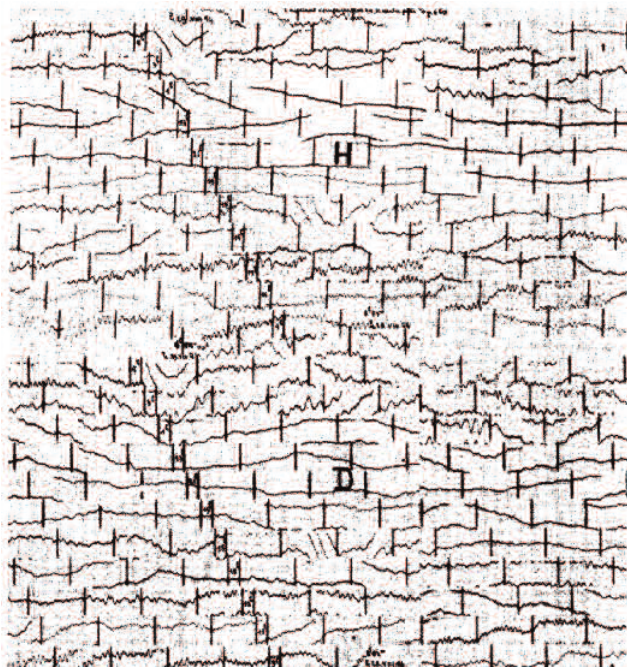
Figure 1. Aspect d'une journée peu agitée (Fragment d'enregistrement à Chambon-la-Forêt, 28 au 29 août 1954; variomètres magnétiques hori- zontaux de Gibault, enregistreur rapide de La Cour). Il y a 5 minutes entre deux traits verticaux, environ deux heures entre deux lignes